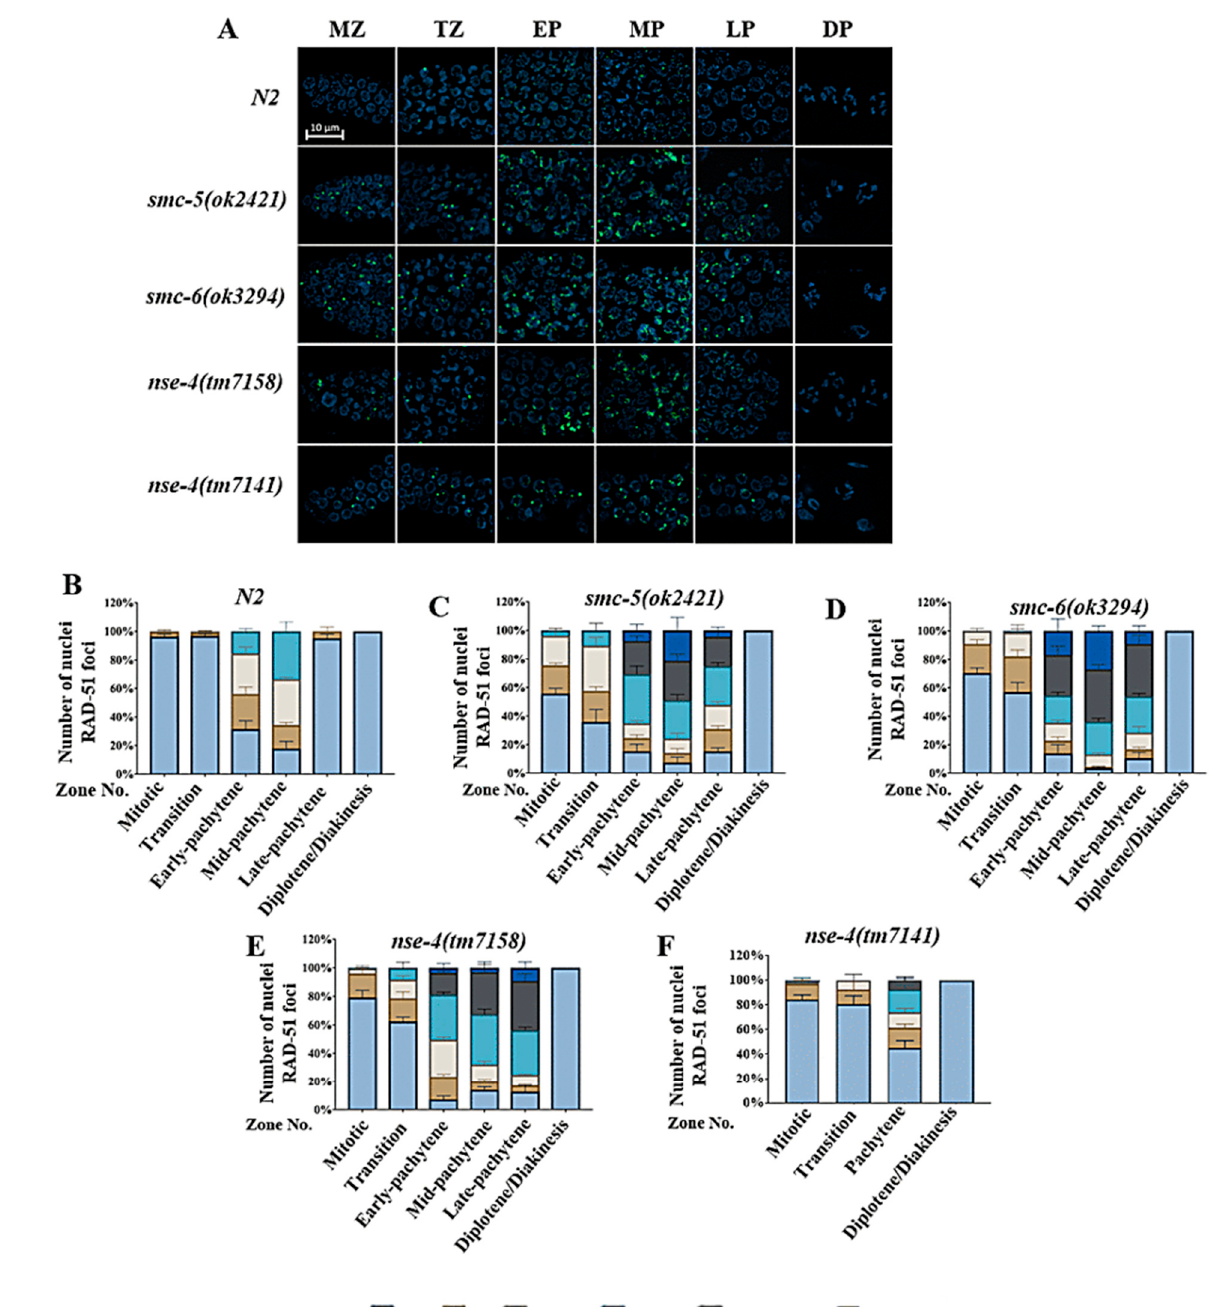
Figure 4. Abnormal RAD-51 accumulation in meiotic germ cells of nse-4 mutants. ( A ) Micrographs of RAD-51 immunofluorescence and DNA-DAPI fluorescence at the different zones of wild-type and mutant germlines images were captured using a Zeiss confocal microscope LSM 800 with Airyscan at 63 × objective with oil immersion (scale bar = 10 µ m). ( B – F ) Distribution of RAD-51 foci in the germline is shown in the various zones of the gonad arms. Different colors represent the average number of RAD-51 foci per nucleus. Error bars represent standard error (±S.E.M).